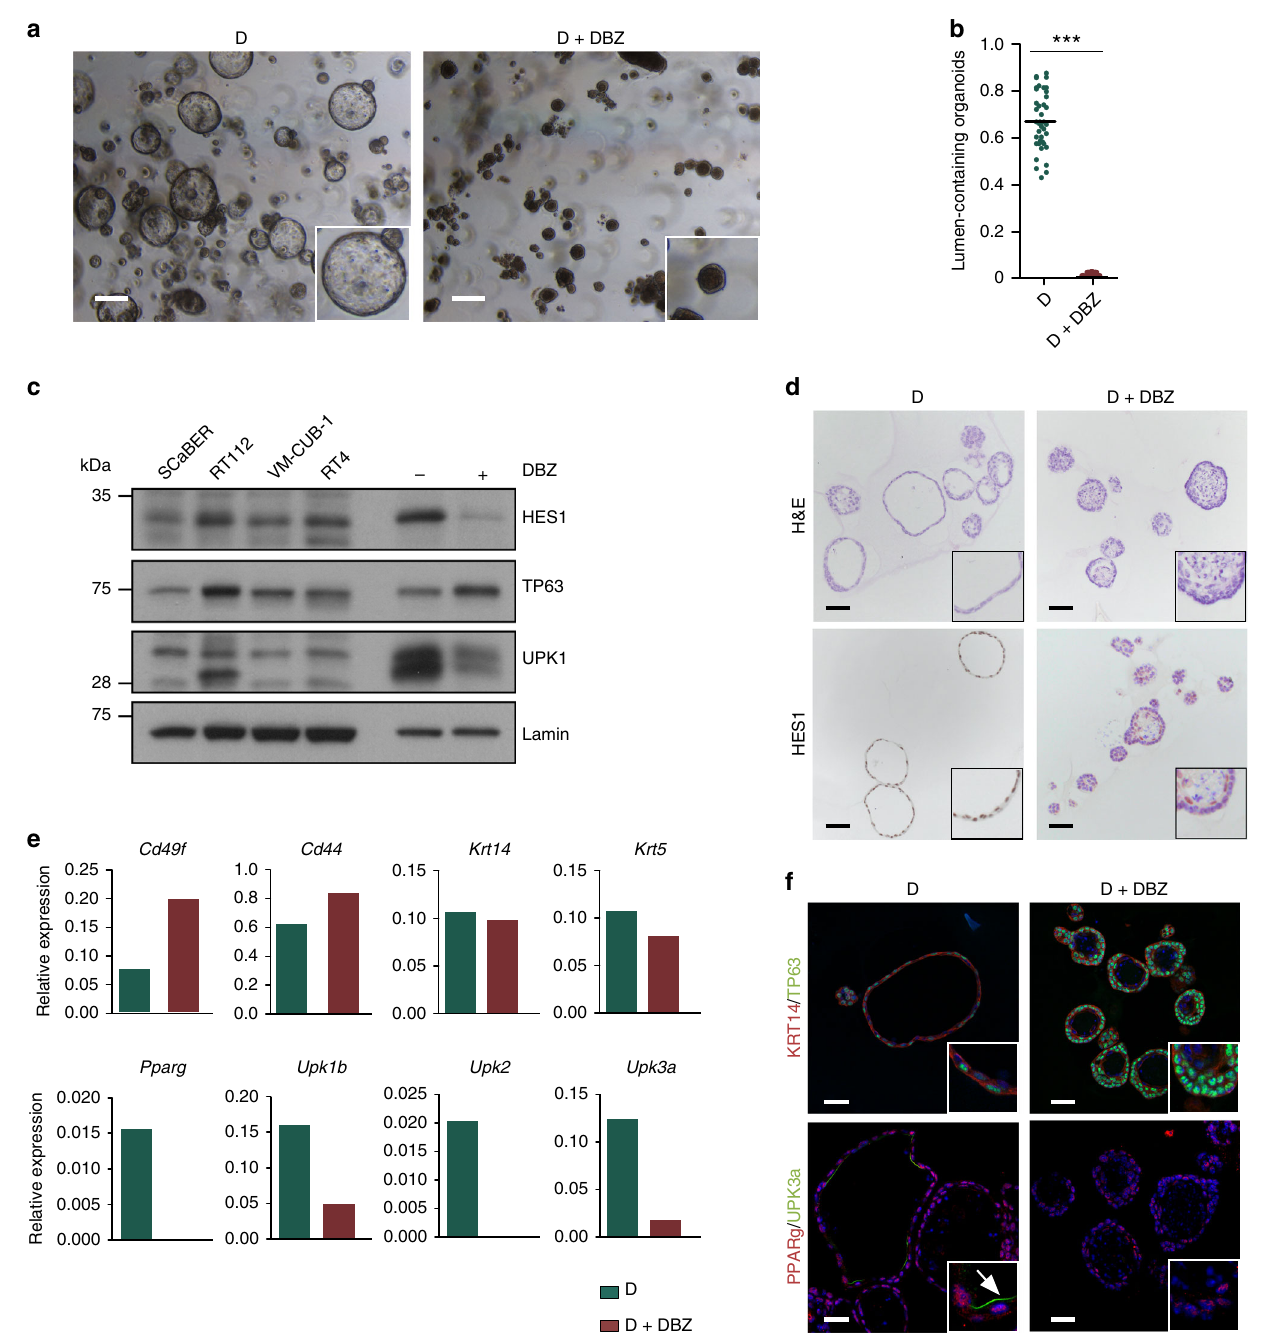
Fig. 7 Notch pathway inhibition prevents the differentiation of urothelial organoids. a Phase contrast images of D organoids cultured in the presence of the γ -secretase inhibition ( n = 4) (scale bar, 500 μ m). b Quanti fi cation of the effects of DBZ on lumen formation (Mann – Whitney test). c Western blot analysis showing the expression of TP63 (basal marker), UPK3a, and UPK1b (luminal markers). d H&E and HES1 expression in organoids treated with DBZ (scale bar, 250 μ m). e RT – qPCR analysis of expression of Notch target genes, proliferation, and urothelial differentiation markers in D organoids treated with DBZ; results were normalized to Hprt expression. f Immuno fl uorescence highlighting TP63 upregulation and UPK3a donwregulation upon treatment with DBZ (scale bar, 250 μ m). *** p ≤ 0.001. Source data are provided as a Source Data fi